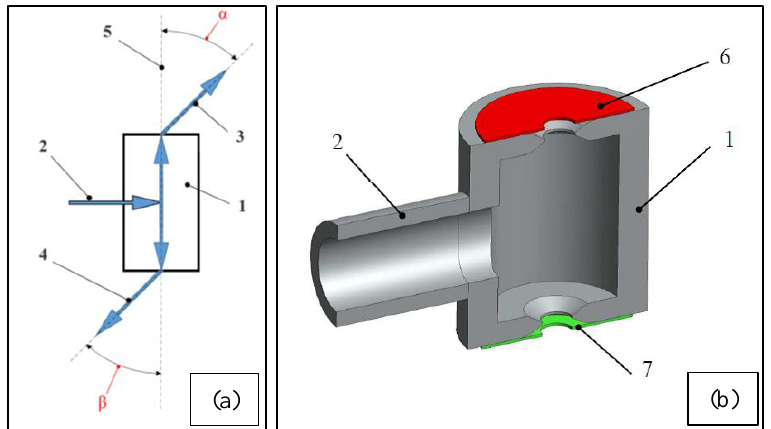
Figure 18. Switchgear diagram – variant No. 1 and a 3D model: 1- switchgear; 2- inlet channel; 3 and 4- gas jet; 5- axial line; 6- upper movable diaphragm; 7- the bottom movable diaphragm. Radial displacement of diaphragms 6 and 7 changes the angles “∝” and “β” . In extreme positions, the diaphragm can completely block the flow